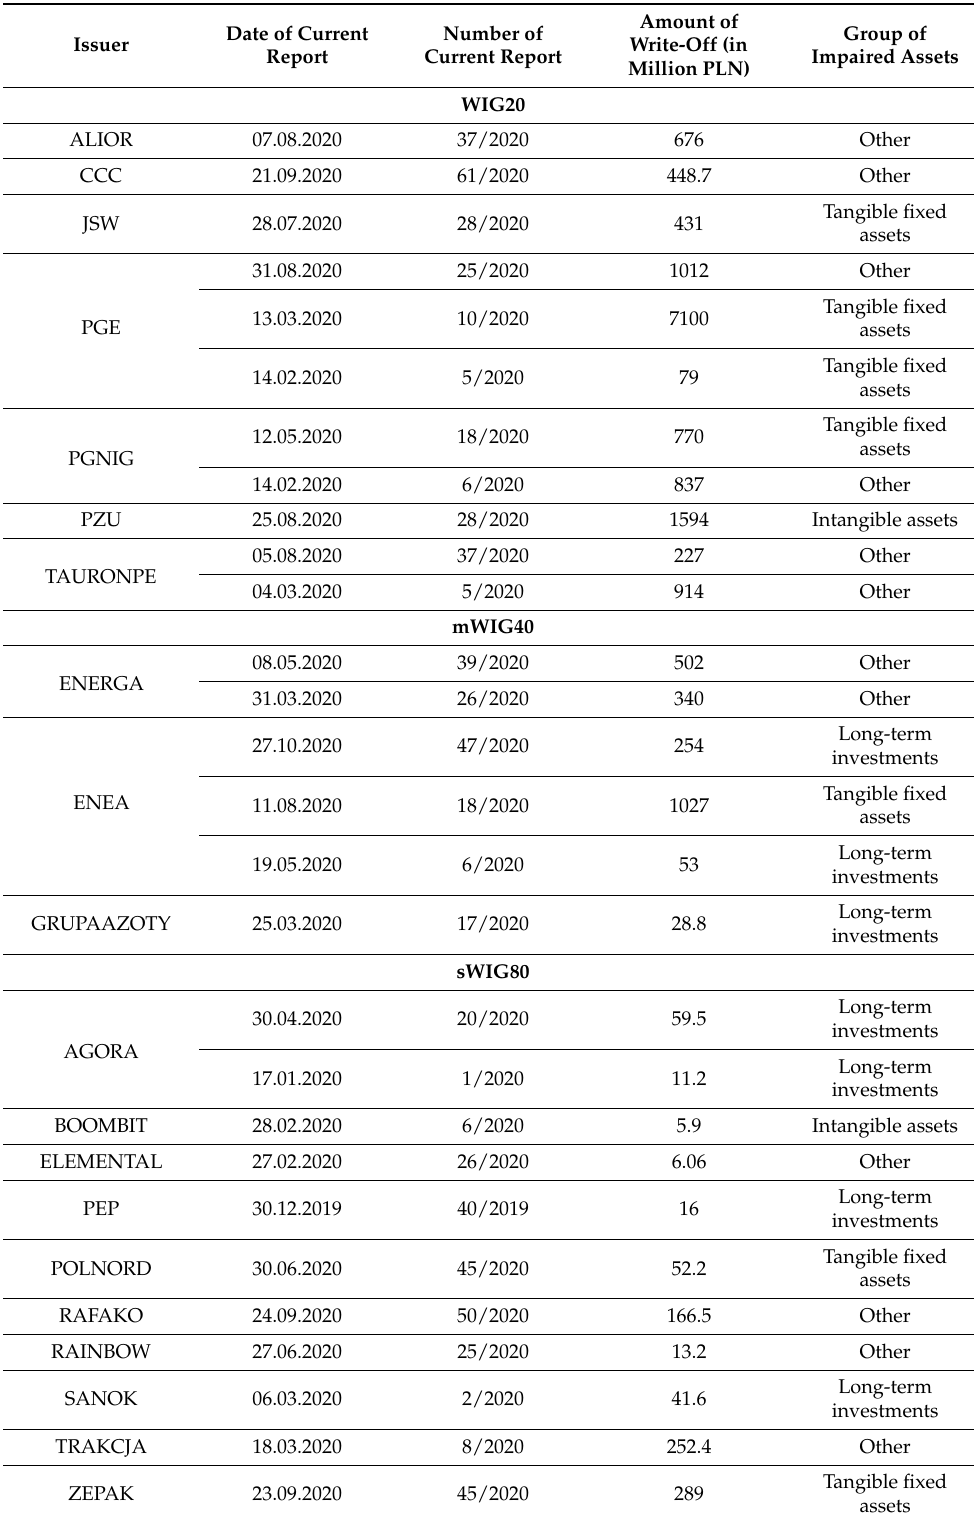
Table 2. All qualified cases of current reports about impairment of assets submitted by issuers